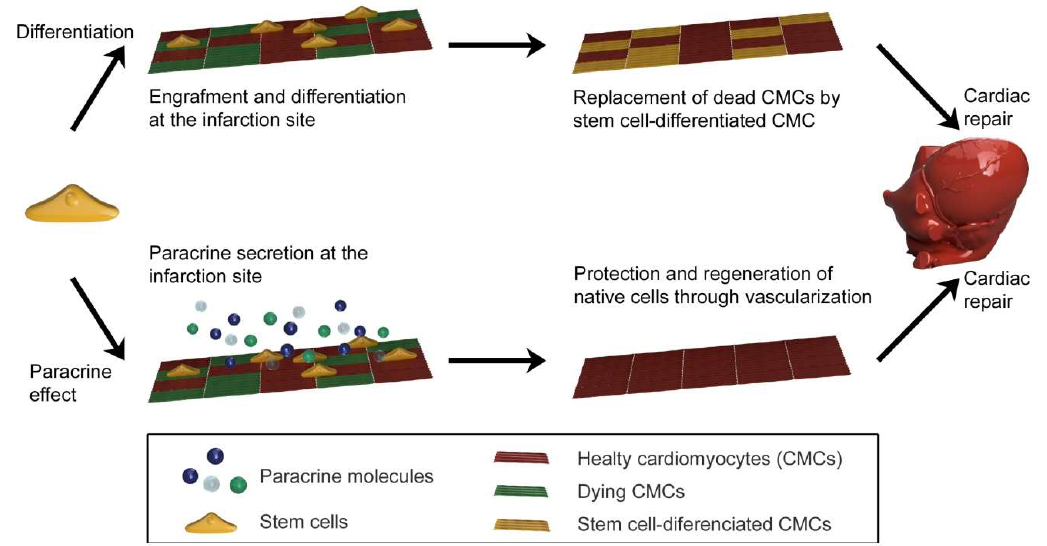
Figure 7. The therapeutic mechanism of dead cells replacement in cardiac tissue by stem cells.